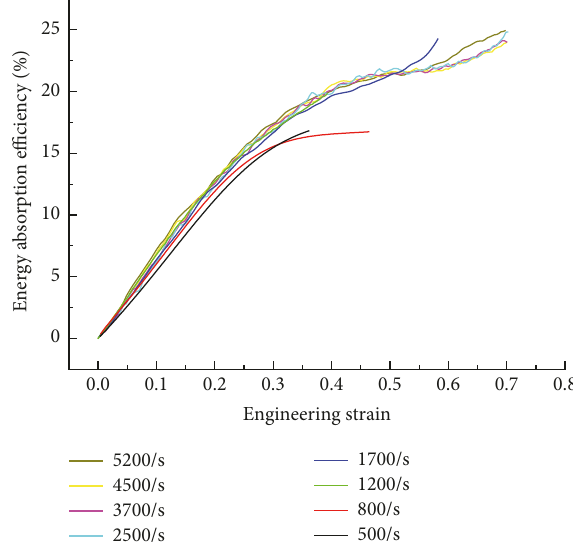
Figure 10: Curves of energy absorption efficiency of high-damping